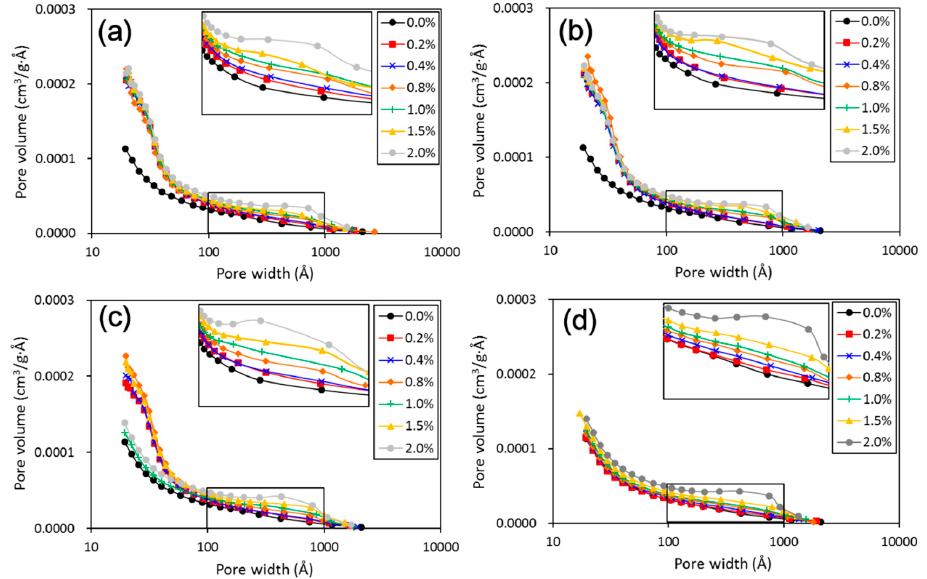
Figure 10. Pore volume versus pore width of treated loess at different nano-SiO 2 content and curing duration. ( a ) 7 days; ( b ) 14 days; ( c ) 28 days; and ( d ) 60 days.